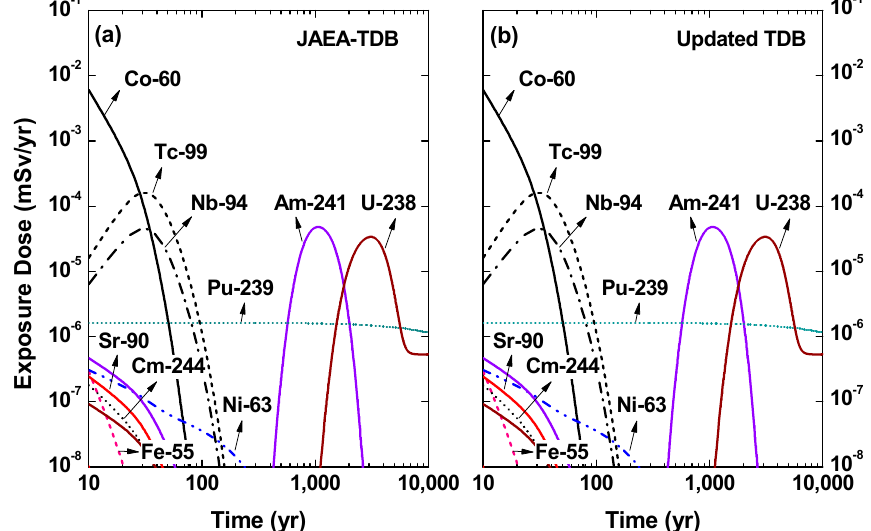
Figure 1. Exposure dose from various radionuclides derived by using solubility data estimated from ( a ) JAEA-TDB and ( b ) updated TDB as the source term.